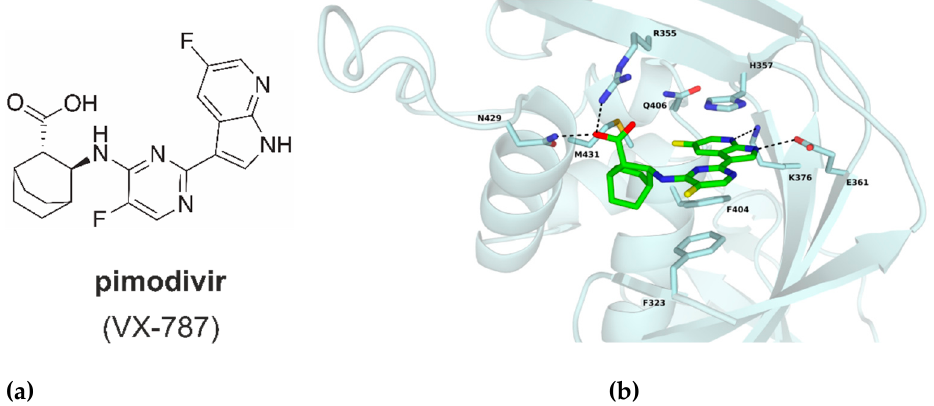
Figure 2. ( a ) Chemical structure of pimodivir (VX-787). ( b ) Cap-binding site of PB2-WT with bound pimodivir (green); ligand, interacting residues and M431 are in stick representation, hydrogen bonds shown as dash lines. PDB code 7SA0 (this manuscript).